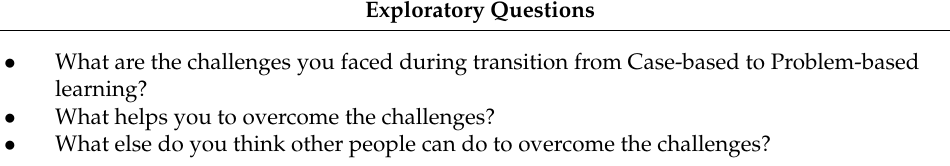
Table 1. Example of focus group